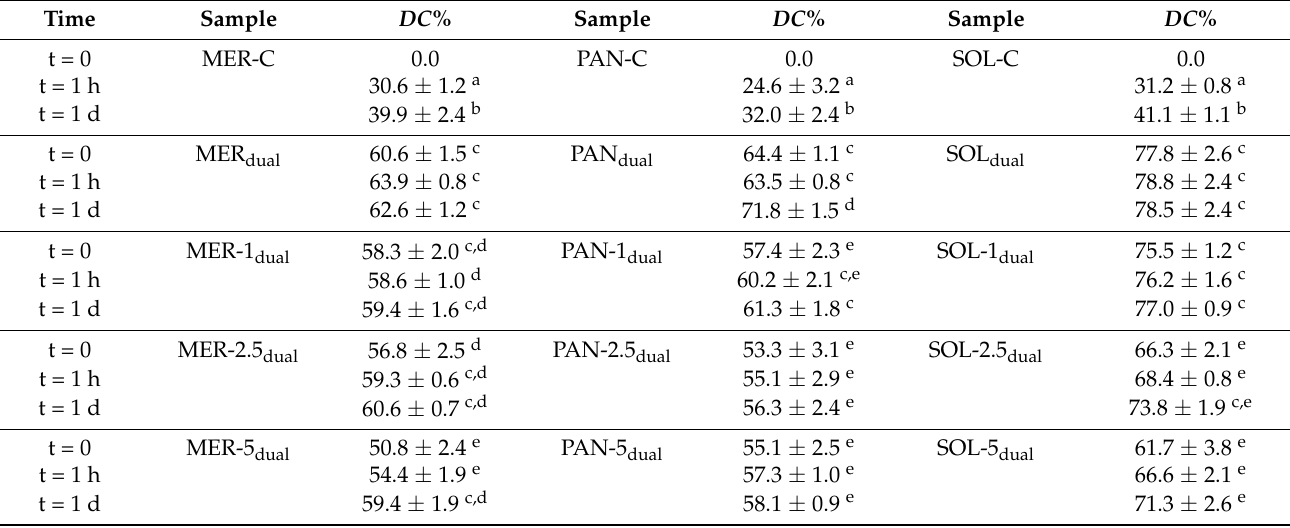
dual = Meron plus QM after dual curing, MER-1 dual = Meron plus QM with 1% zirconia NPs after dual curing, MER-2.5 dual = Meron plus QM with 2.5% zirconia NPs after dual curing, MER-5 dual = Meron plus QM with 5% zirconia NPs after dual curing, SOL dual = Solocem after dual curing, SOL-1 dual = Solocem with 1% zirconia NPs after dual curing, SOL-2.5 dual = Solocem with 2.5% zirconia NPs after dual curing, SOL-5 dual = Solocem with 5% zirconia NPs after dual curing, PAN dual = Panavia SA Universal after dual curing, PAN-1 dual = Panavia SA Universal with 1% zirconia NPs after dual curing, PAN-2.5 dual = Panavia SA Universal with 2.5% zirconia NPs after dual curing, PAN-5 dual = Panavia SA Universal with 5% zirconia NPs after dual